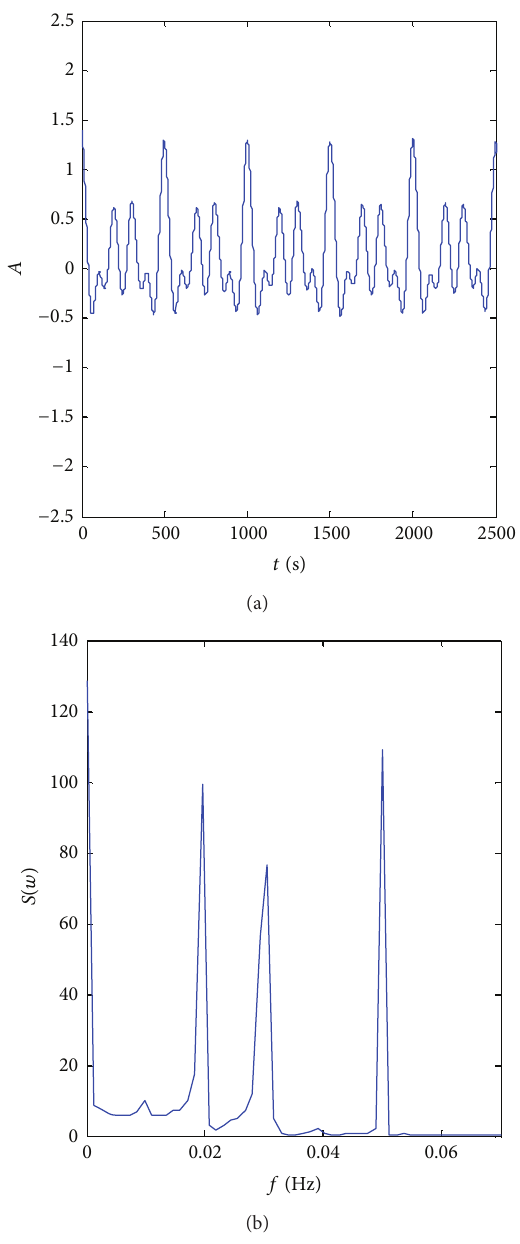
Figure 7: (a) The time-domain diagram of stochastic resonance outputsignalaftercorrelationprocessing.(b)Thespectrumdiagram of stochastic resonance output signal after correlation